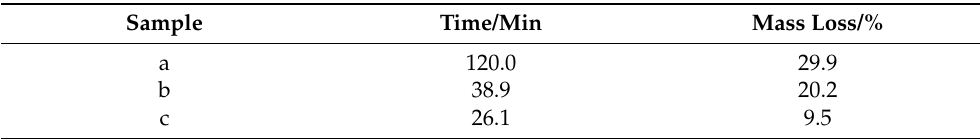
Table 1. The decomposition test conditions of